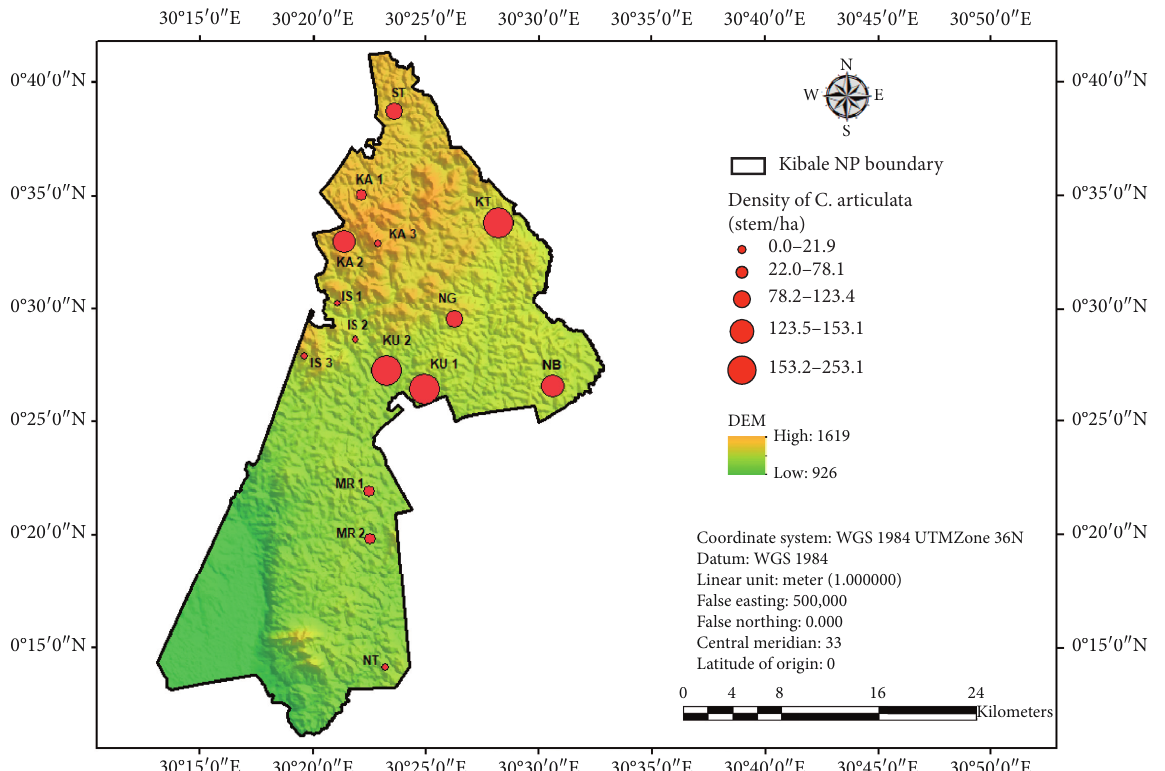
Figure 4: Variability in occurrence of C. articulata in Kibale National Park. KA, Kanyawara; ST, Sebitoli; IS, Isunga; NG, Ngogo; KU, Kanyanchu; MR, Mainaro; NB, Nyamibiriko; NT, Nyabitusi; KT,